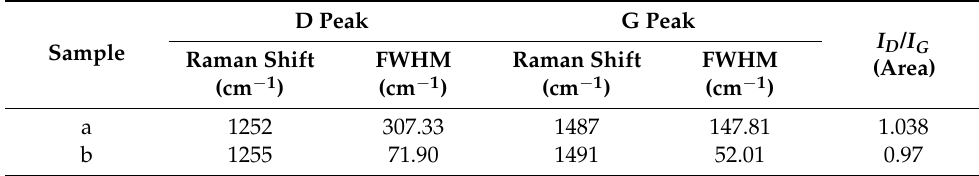
Figure 7. Structural analysis result by Raman spectroscopy. ( a ) Raman spectra of untreated electrode. ( b ) Raman spectra of treated electrodes. Table 3. Calculated Results of Raman Analysis.